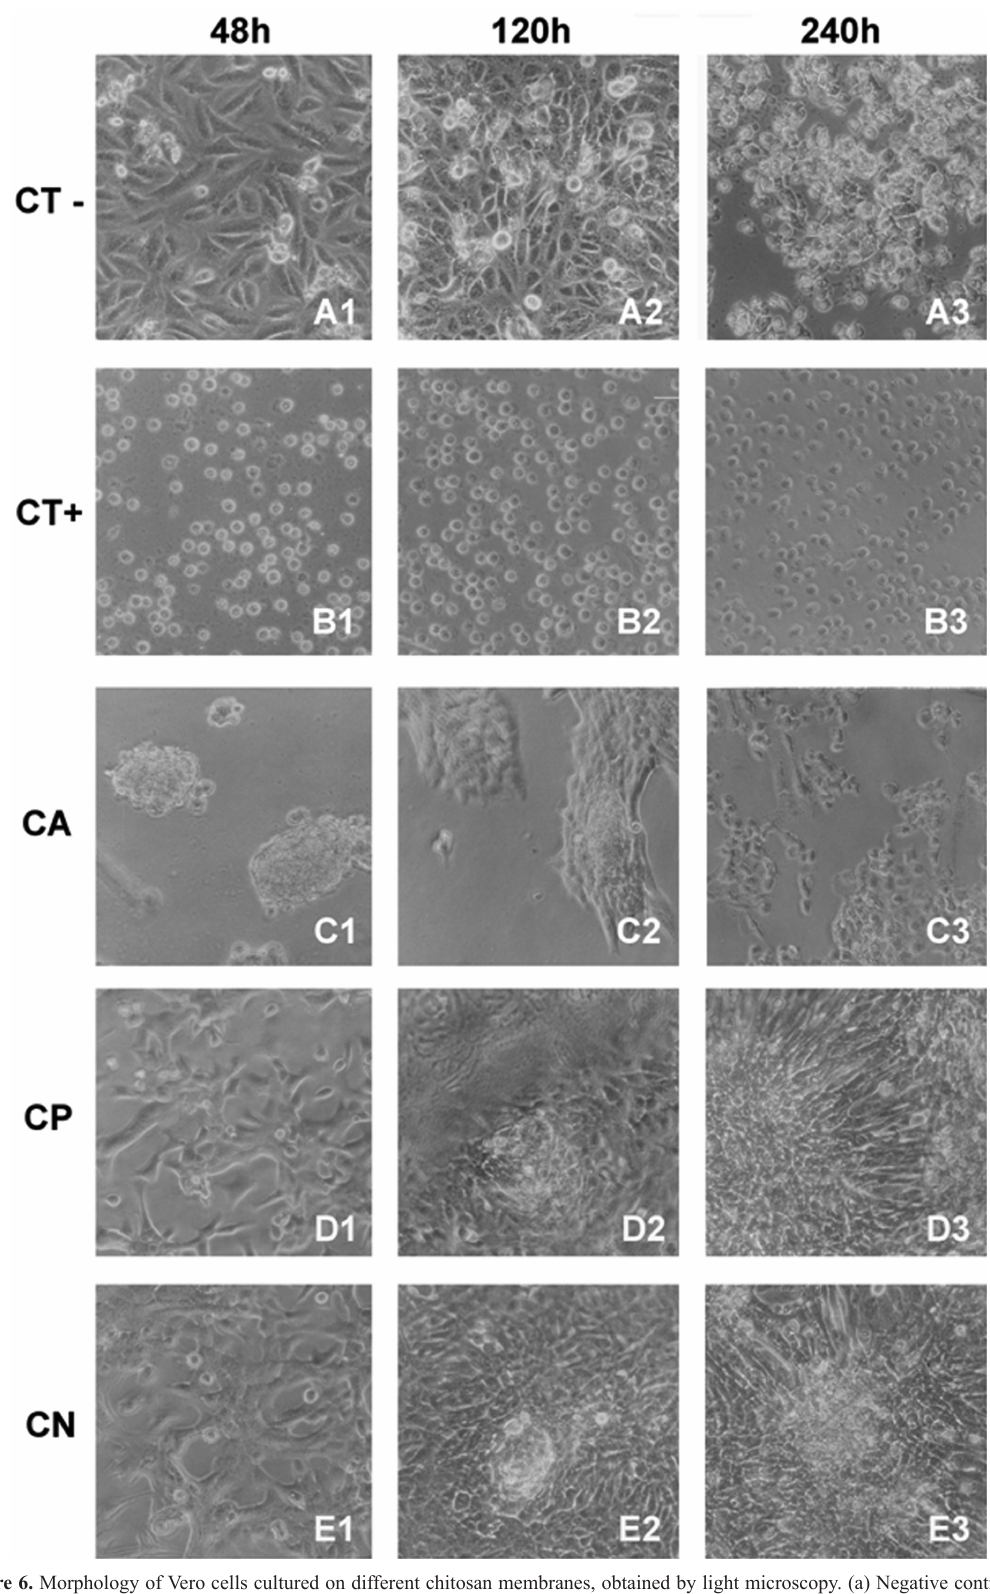
Figure 6. Morphology of Vero cells cultured on different chitosan membranes, obtained by light microscopy. (a) Negative control for cytotoxicity (CT-); (b) Positive control for cytotoxicity (CT+); (c) Chitosan membrane (CA); (c) Chitosan neutralized membrane (CN); (e) Sorbitol-chitosan plasticized membranes (CP). All assays were performed for 48, 120 and 240hs of